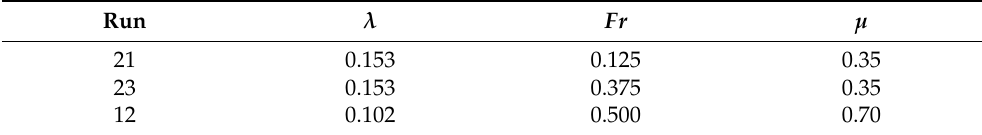
Table 1. Dimensionless parameters used in the landslide experiment of Whittaker et al. [34]. Run